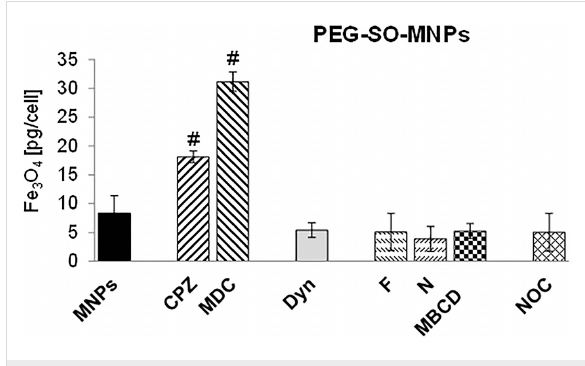
Figure 2: The effect of endocytic inhibitors on the internalization of PEG-SO-MNPs. MNPs – PEG-SO-MNPs (2 mM), CPZ – chlorpro- mazine (25 µM), MDC – monodansylcadaverine (150 µM), Dyn – dyna- sore (80 µM), F – filipin (5 µM), N – nystatin (20 µM), MBCD – methyl- β -cyclodextrin (100 uM), NOC – nocodazole (25 µM). Data are given as mean values ± SD from at least two independent experiments carried out